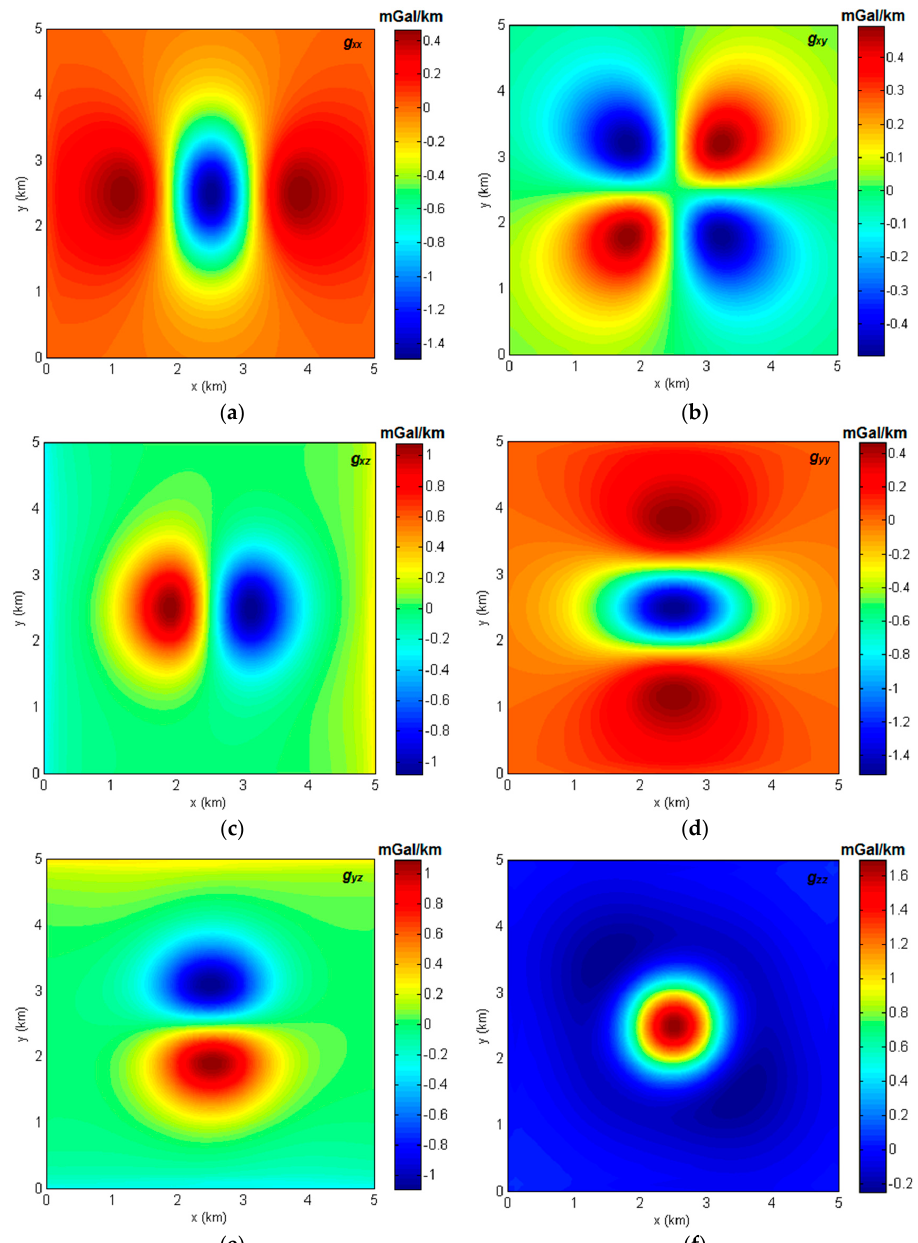
Figure 7. The gravity gradient tensor obtained from forward modeling calculation of the rectangular prism model, ( a ) g xx ; ( b ) g xy ; ( c ) g xz ; ( d ) g yy ; ( e ) g yz ; ( f ) g zz